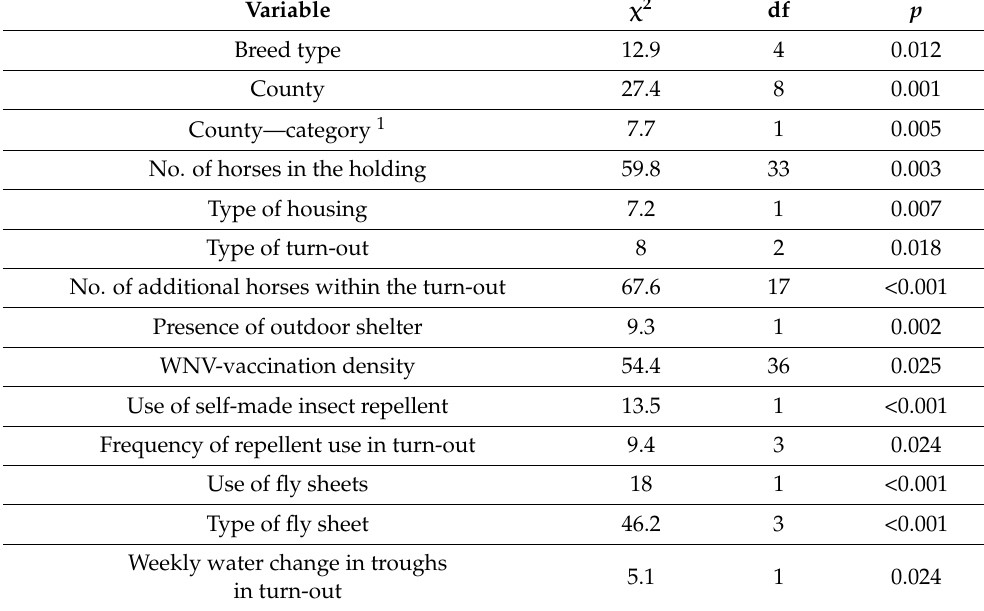
Table 2. Univariate analysis (chi-square) of potential risk factors for WNV seropositivity (based on VNT results) in 937 horses in Eastern Germany. Only significant variables ( p < 0.05) are shown.